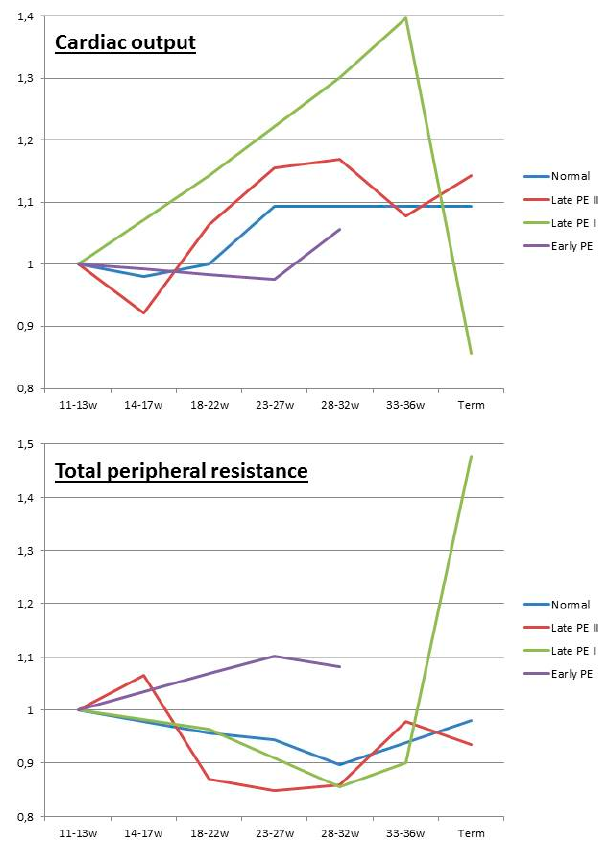
Figure 5. Longitudinal changes in cardiac output and peripheral resistance, expressed as a product of 12-week measurements, reported in normal pregnancies [125], early-onset preeclampsia [114], late-onset preeclampsia type I (cross over) [38], and late-onset preeclampsia type II (high output) [37]. In normal pregnancies, the cardiac output increases to a plateau from the second trimester until term, whereas the total peripheral resistance reaches a nadir in the early third trimester to increase again until term [125]. Early-onset preeclampsia presents with high total peripheral resistance from the first trimester onward, combined with a poor increase in cardiac output [114]. Late-onset preeclampsia type I presents with a normal change in peripheral resistance, but a more pronounced increase in cardiac output until the third trimester, when a fast crossover occurs from a high output / low resistance circulation to a low output / high resistance circulation [38]. Late-onset preeclampsia type II shows high cardiac output and low peripheral resistance throughout all stages of pregnancy in a population of mainly obese women [37].